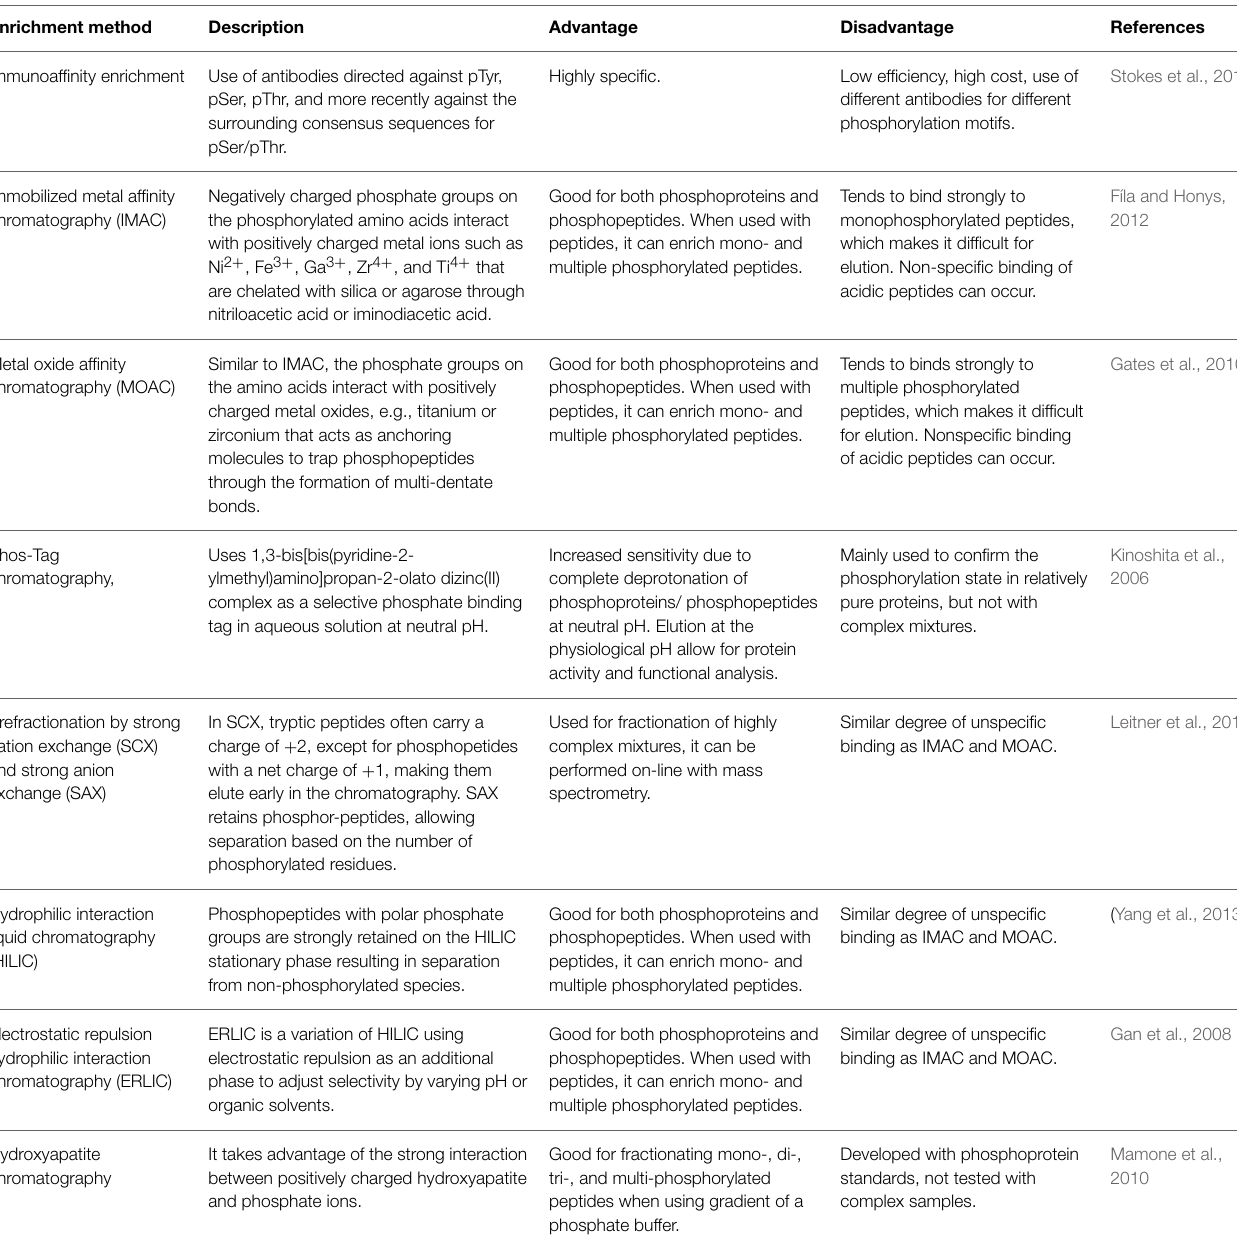
TABLE 1 | Phosphopeptide/phosphotprotein enrichment